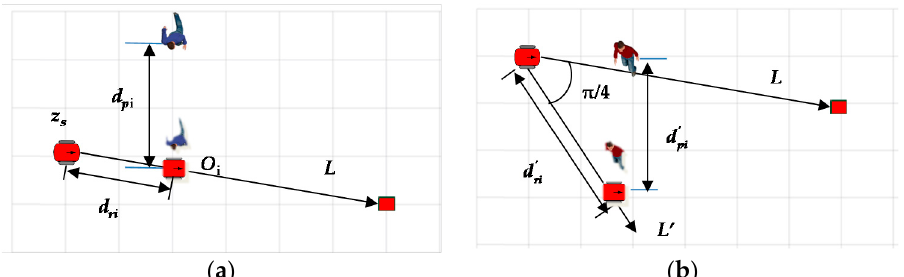
Figure 4. Calculation of the trajectory chasing cost in G f ( p i ) for p i in different velocity ranges: ( a ) (1.2 m/s, 3 m/s); ( b ) [0.5 m/s, 1.2 m/s].